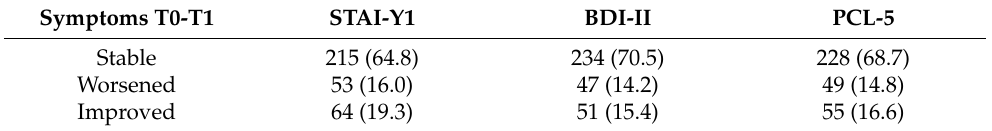
Table 3. Number (percentage) of participants who reported a significant change in psychopathological symptoms or remained stable between T0 and T1 (N =